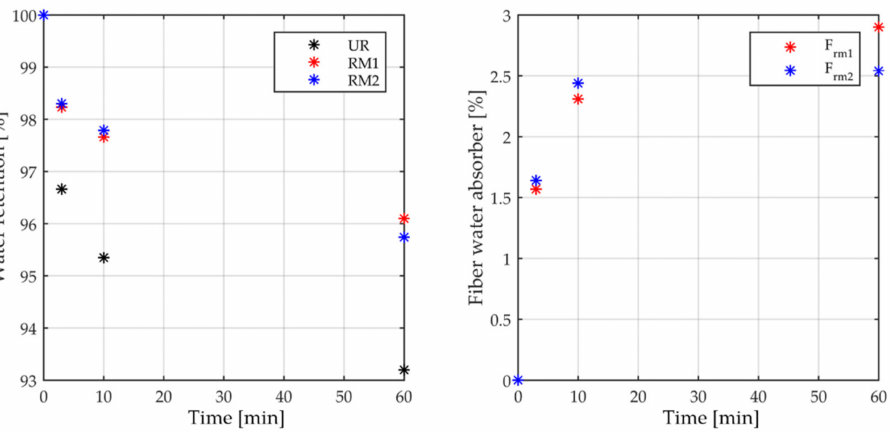
Figure 11. On the ( left ): average values of the water retention test performed on the mortar reinforced with RM1 and RM2 dispersed fibers. On the ( right ): average values of the fiber water absorbed by the two